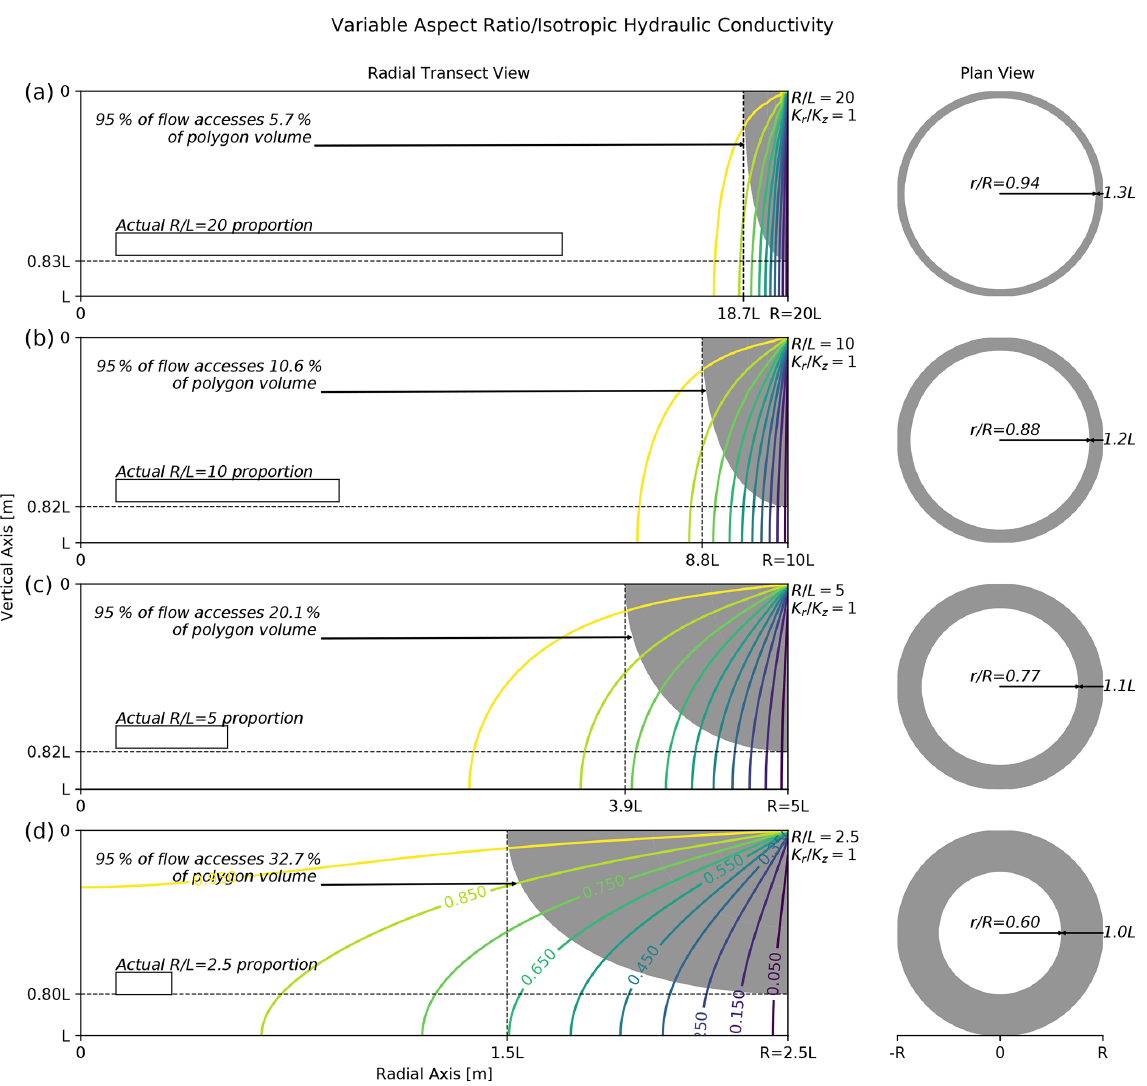
Figure 4. Effect of polygon aspect ratio on polygon drainage with isotropic hydraulic conductivity. Plots along the left contain polygon radial transect head contours (colored lines) and filled stream tubes (gray regions) for several polygon aspect ratios (radius/thickness). The gray shaded region denotes the portion of the transect accessed by 95% of the flow. The plots along the right contain corresponding gray rings indicating the surface area where 95% of the polygon flow infiltrates. Each plot along the left contains a rectangle drawn to the actual proportions for the given polygon aspect ratio. In all cases, the anisotropy coefficient (horizontal conductivity/vertical conductivity) is fixed at